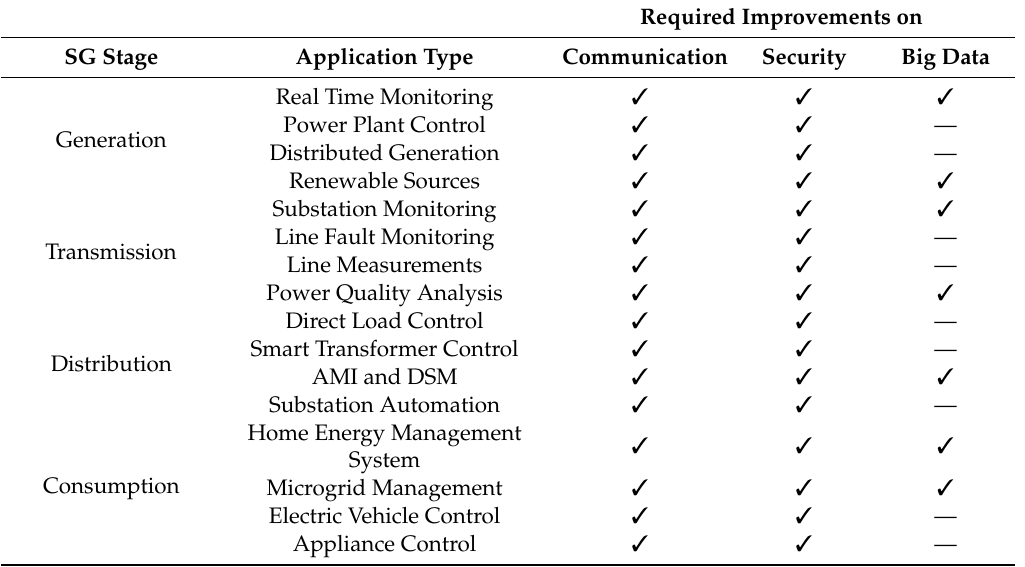
Table 2. Current potential research topics for IoT systems. Advanced metering infrastructure (AMI); demand side management